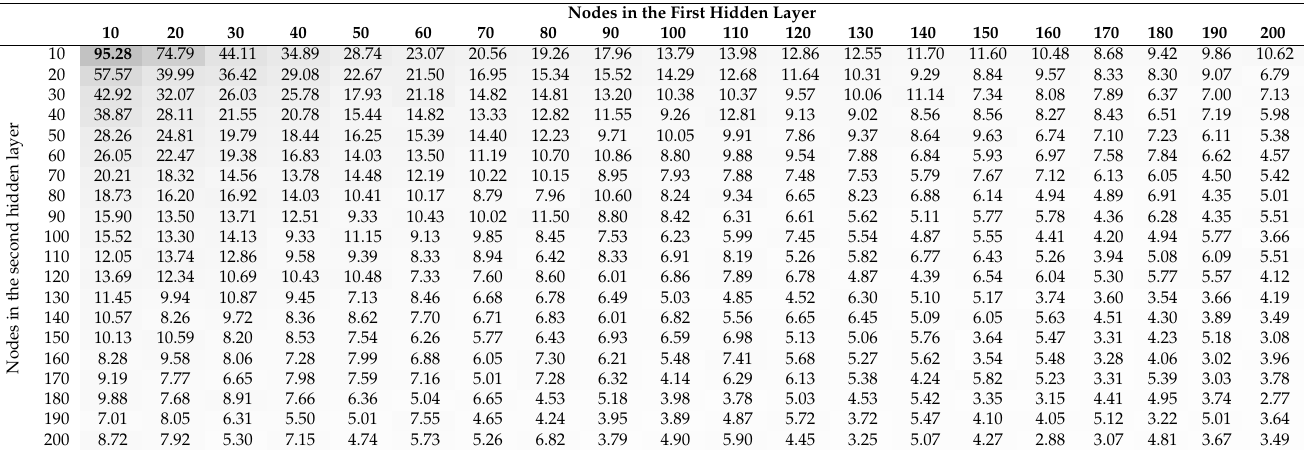
Table A1. Average predictive error (%) for each topology as a function of the amount of nodes in the hidden layers. Nodes in the First Hidden Layer 10